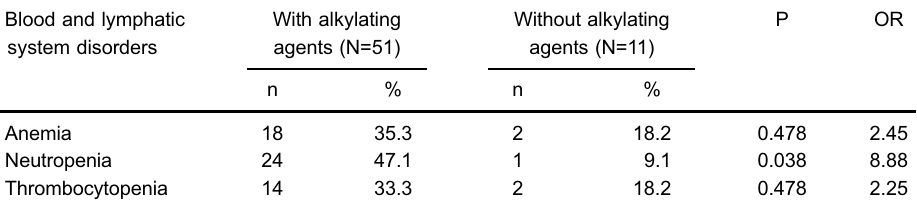
Table 5. Frequency of blood and lymphatic system disorders, according to the presence or not of alkylating agents in the treatment protocol in multiple myeloma patients under treatment with bortezomib, thalidomide, or a combination of both drugs.